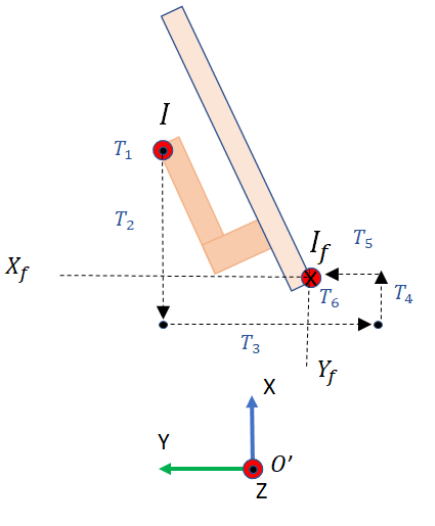
Figure 14. Illustration of the movement of the end effector in phase